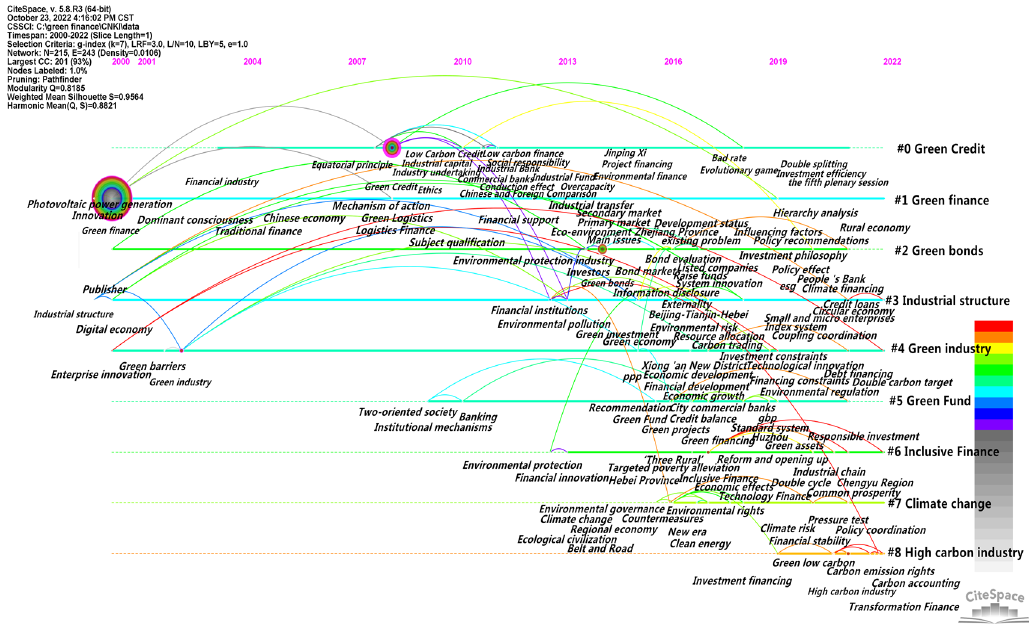
Figure 12. CNKI timeline.